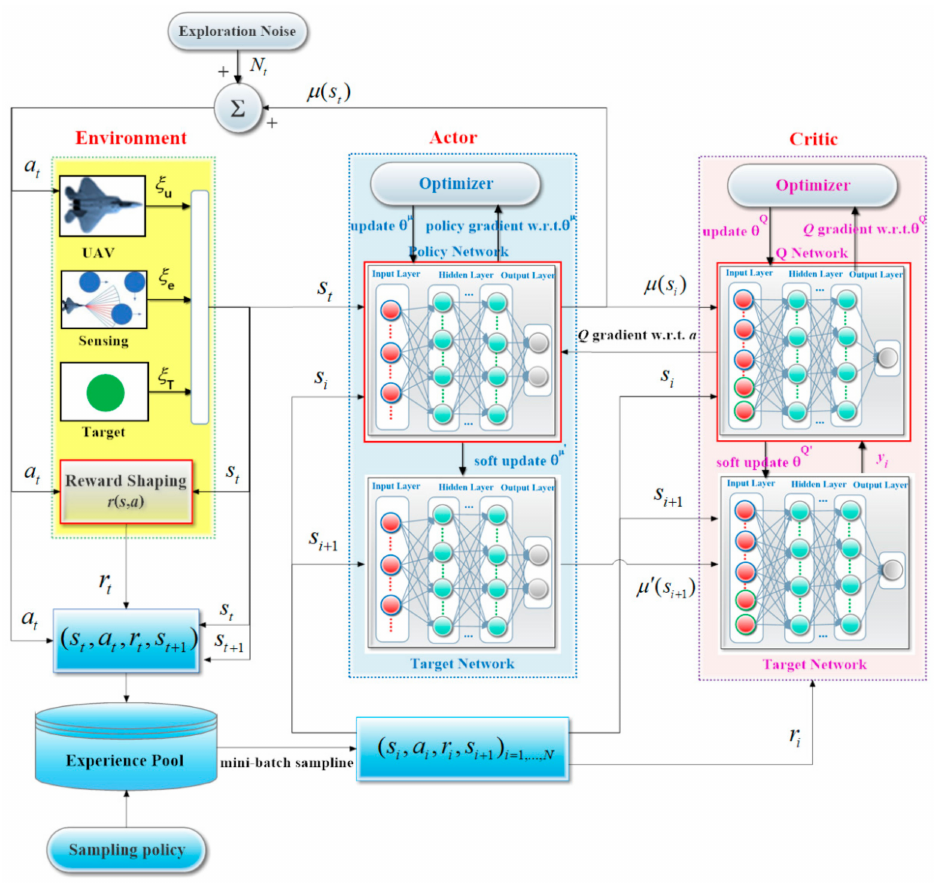
Figure 5. Actor-critic based motion control